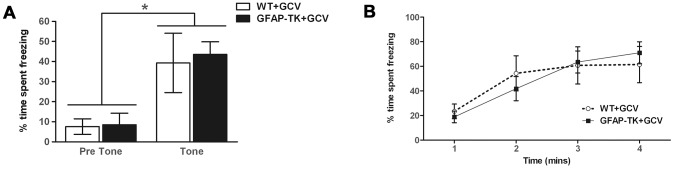
Ablating adult neurogenesis does not affect fear conditioning.
A Freezing behavior of GCV-treated wild type (n = 7) and GFAP-TK (n = 10) rats during 60 s preceding a tone previously paired with a shock (Pre Tone) and during the first 20 s of tone presentation (Tone). Data represent % time spent freezing during each time period (± sem). B Freezing behavior of GCV-treated wild type (n = 7) and GFAP-TK (n = 10) rats in a context previously associated with shock presentation. Data represent % time freezing during 4 minutes (60 s time bins; ± sem). *p<0.05 tone significantly different from pre-tone. Wild type data are represented by an open circle connected by an interrupted line, GFAP-TK data are represented by filled squares and a solid line.